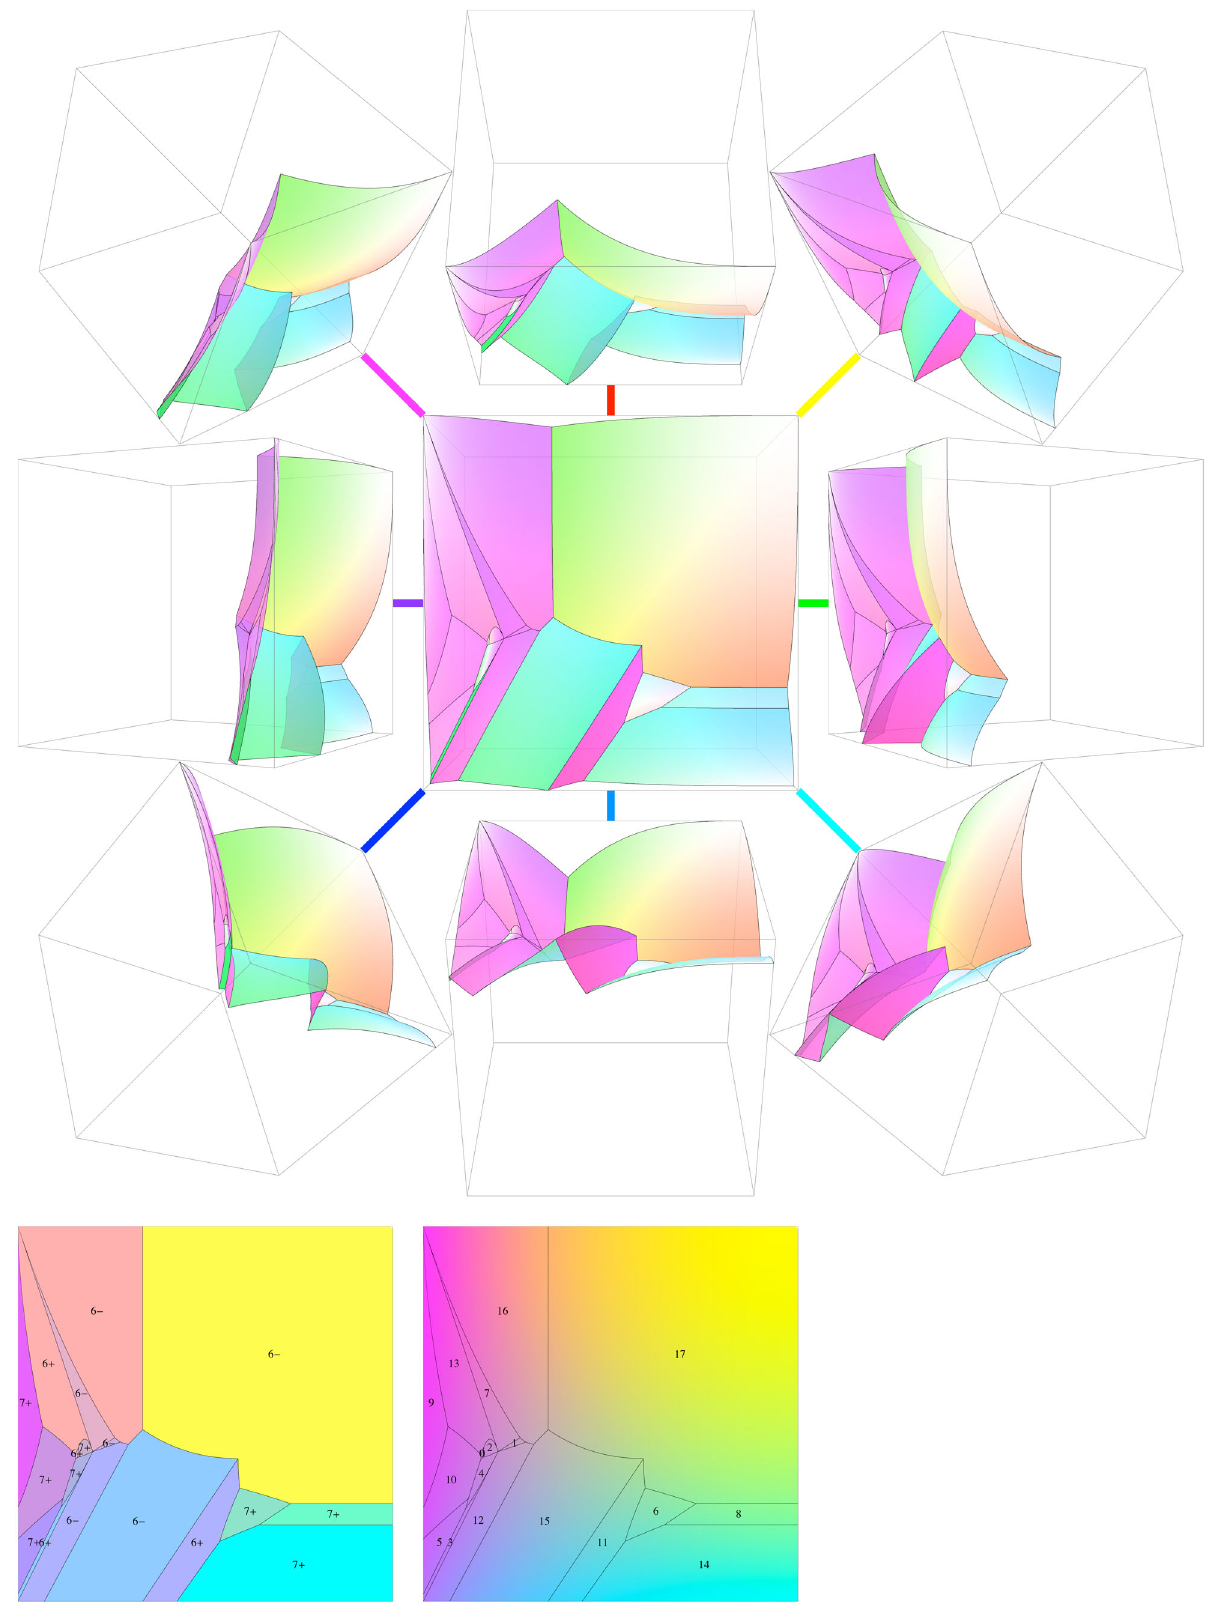
FIG. 6 423-family optimal density surface ( 3 × 3 grid of cubes), parallel contacts (bottom left), face areas, and region size (bottom